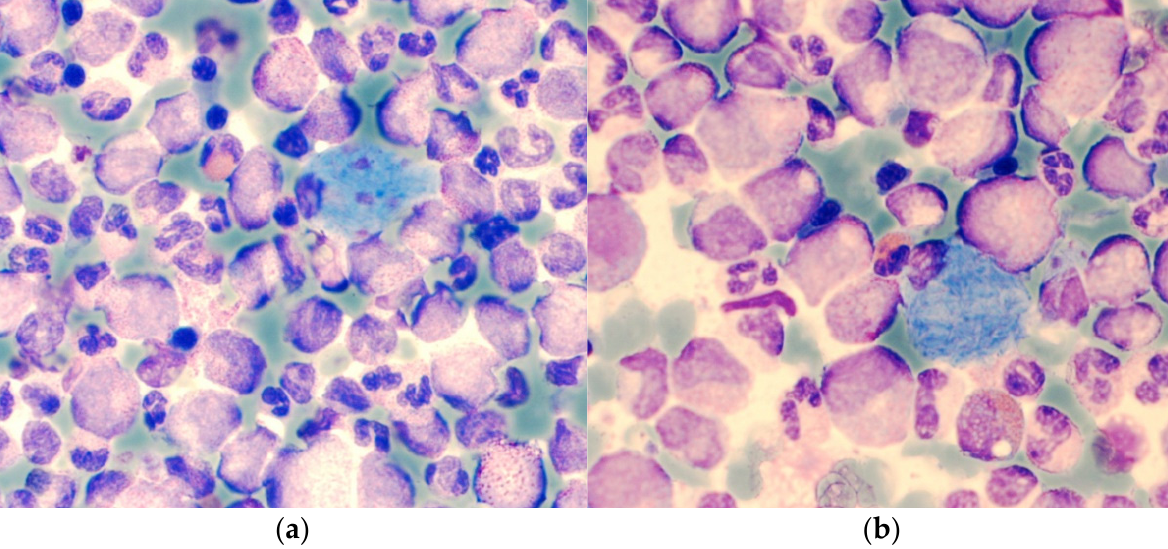
Figure 8. Bone marrow smears showing deep-blue Pseudo Gaucher cells. Magnification 800 ×